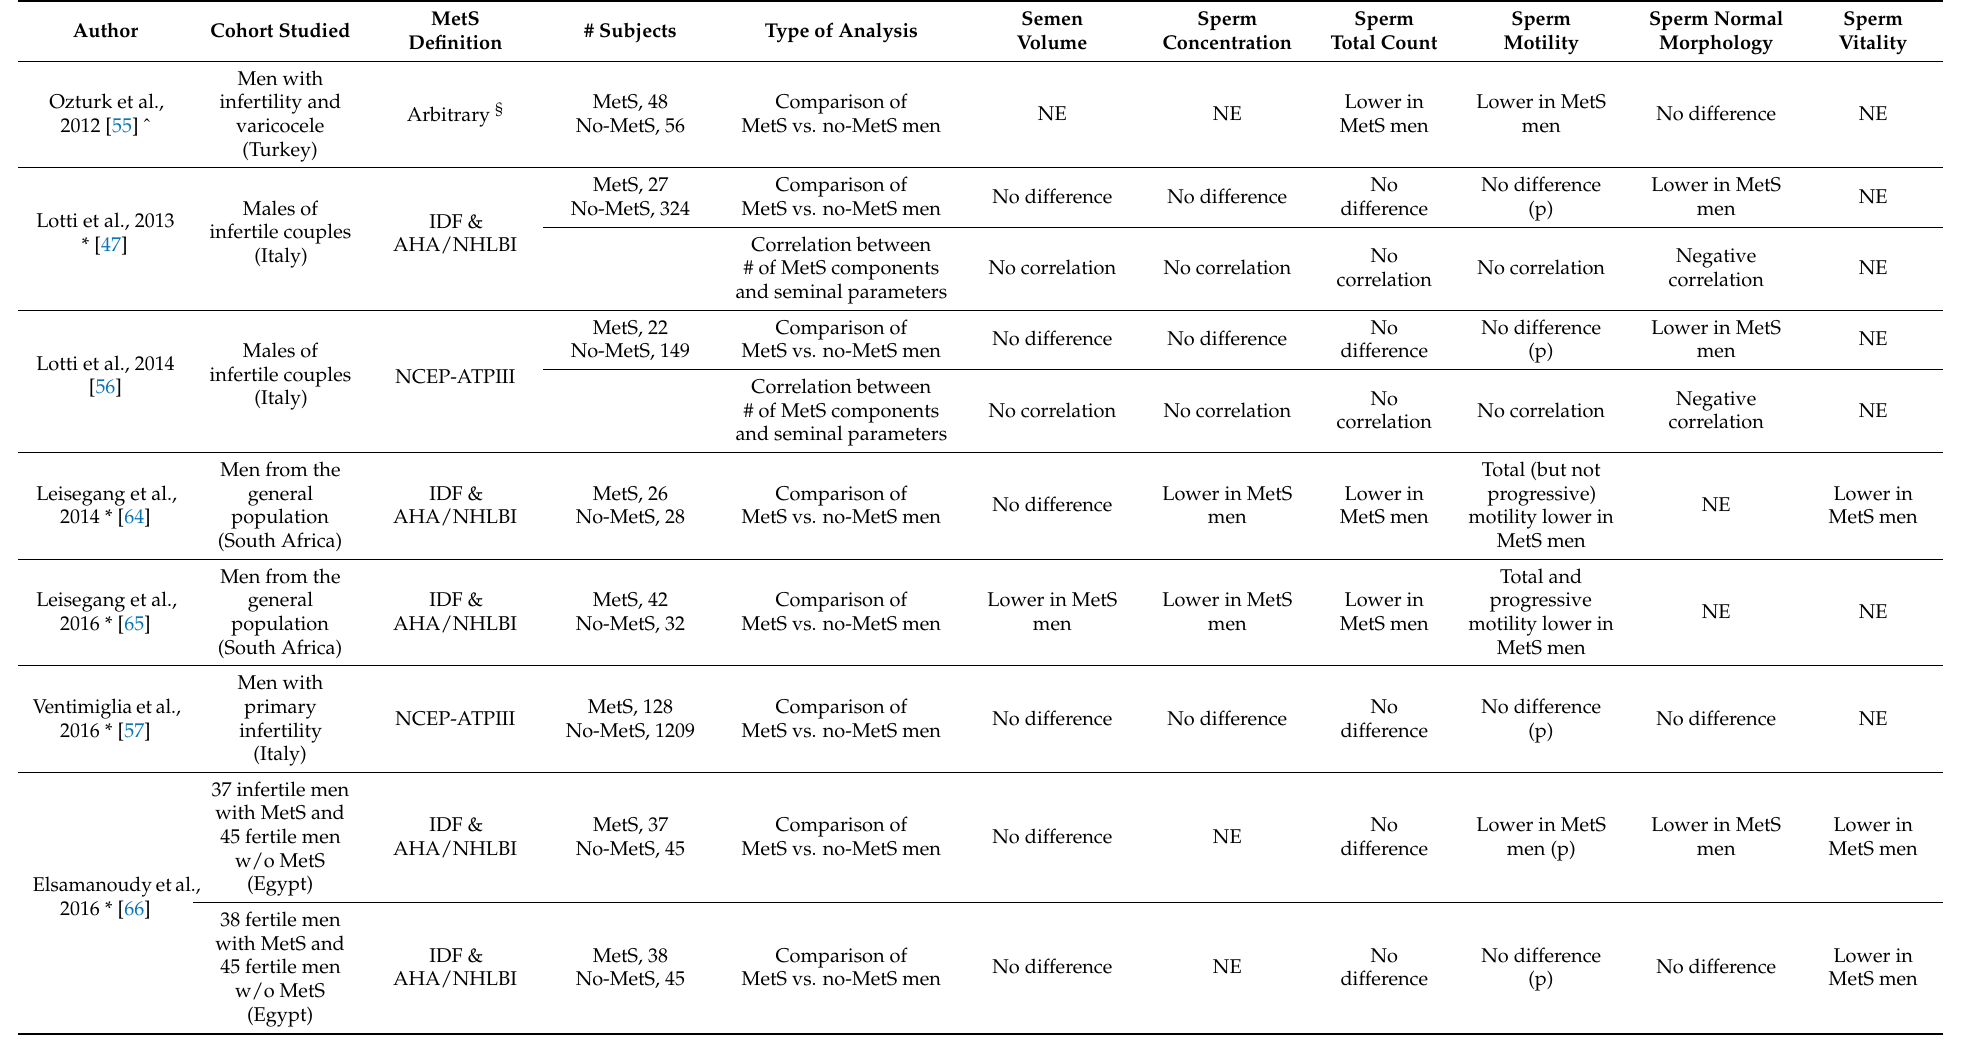
Table 3. Studies investigating the relationship between MetS and “conventional” semen